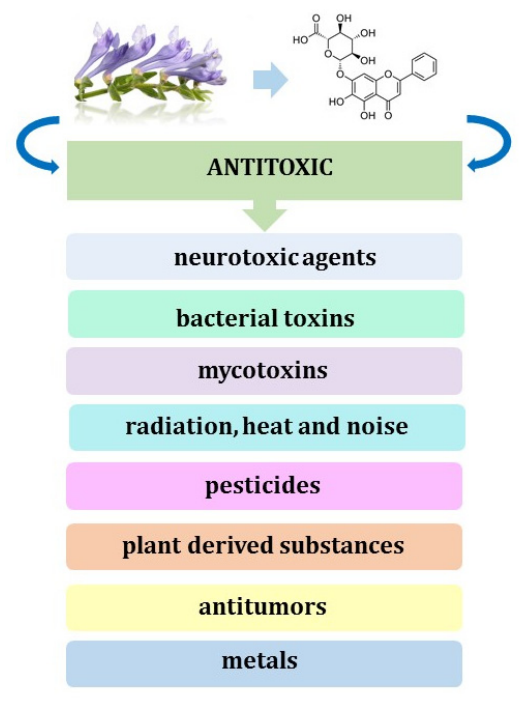
Figure 5. Antitoxic effects of baicalin ( 1 ).